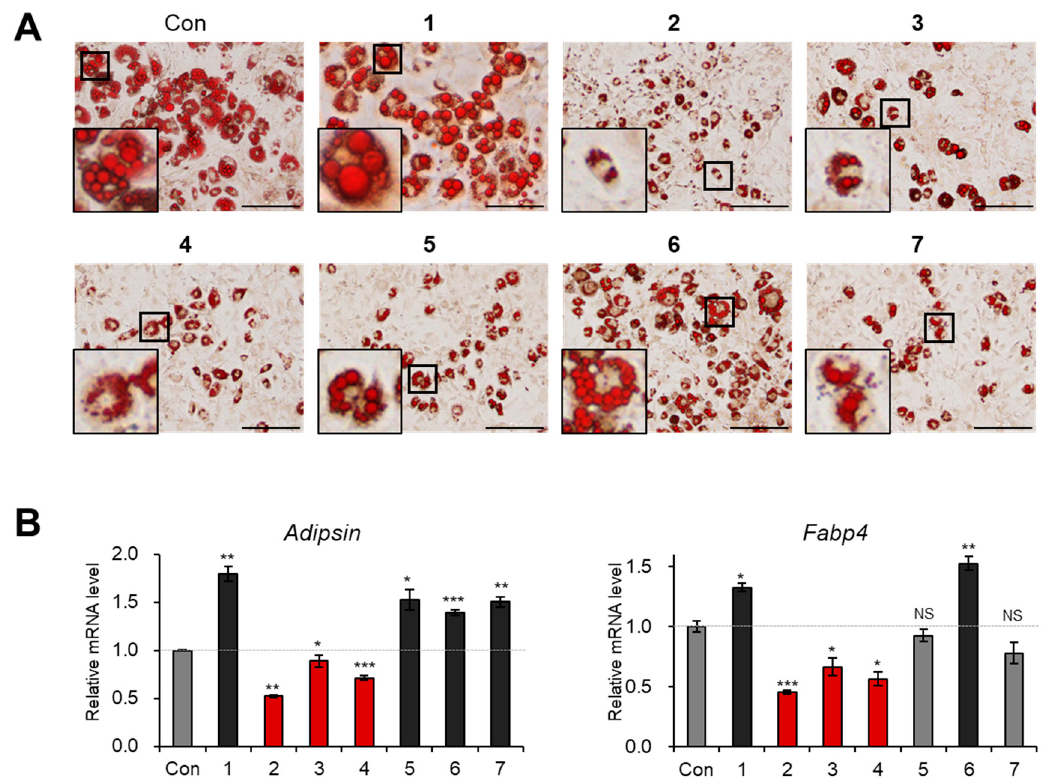
Figure 5. The inhibitory effects of compounds 1 – 7 on adipogenesis. ( A ) The Oil Red O staining of 3T3-L1 adipocytes incubated with compounds 1 – 7 (20 µM) during adipogenesis. Scale bar: 200 µm. 3× magnified images are indicated as black box. ( B ) The relative mRNA expression of Adipsin and Fabp4 in 3T3-L1 adipocytes incubated with compounds 1 – 7 (20 µM) during adipogenesis. The data are presented as the mean ± SEM for n = 3 replicates. * p < 0.05, ** p < 0.01, *** p < 0.001 and NS: not significant.